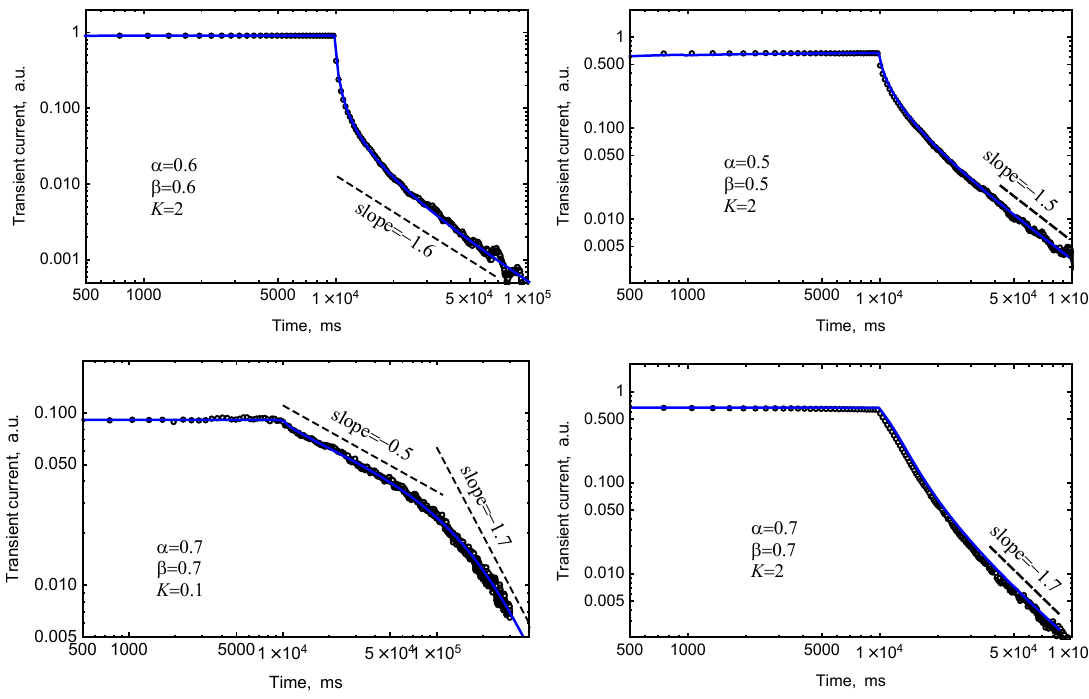
Figure 4. Transient current curves for various values of 0 < α = β < 1 and K in comparison with the Monte Carlo simulation results.